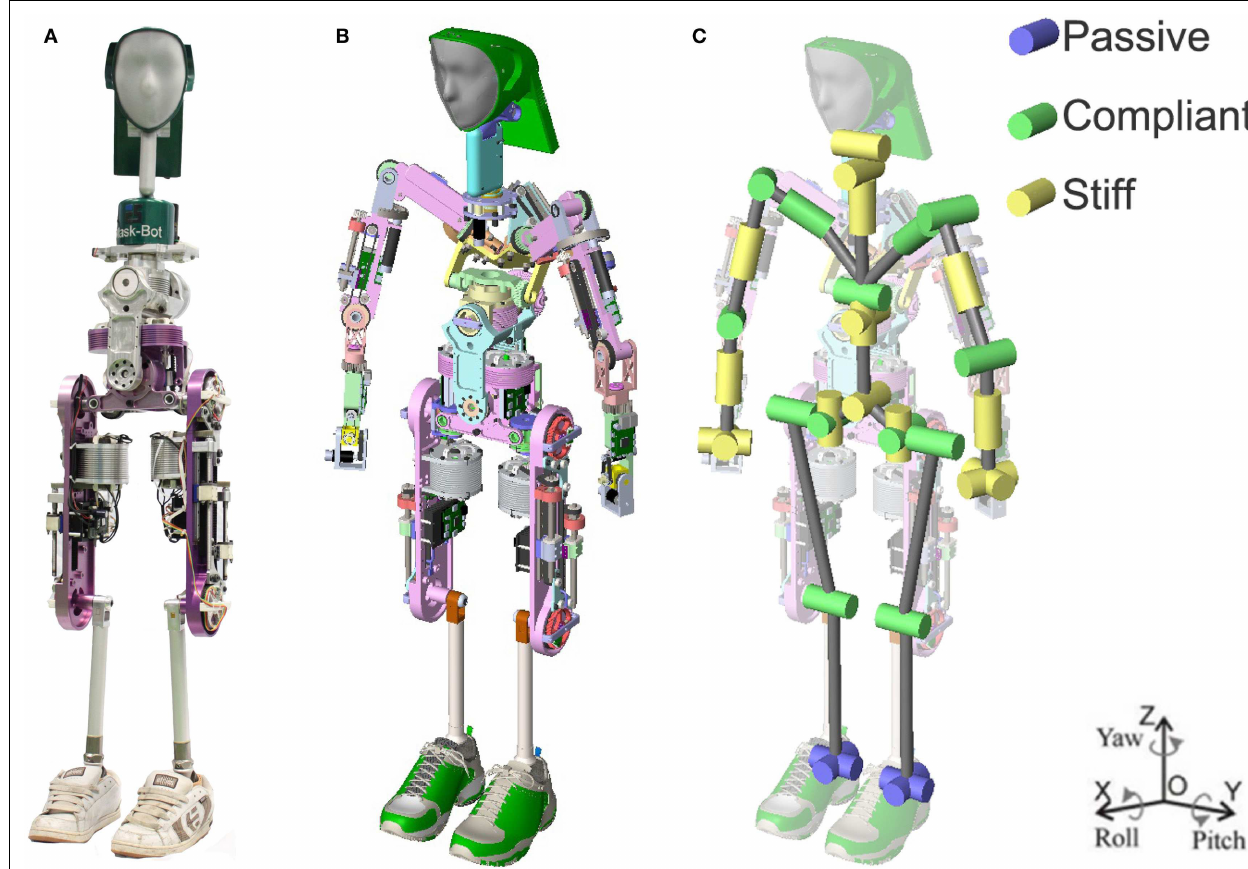
neck, 4 DOFs waist, 7 DOFs arms; passive (4 DOFs): 2 (cid:2) ankles. The purple DOFs are the passive prosthesis. The green DOFs are the compliant leg joints and the yellow are the low cost stiff